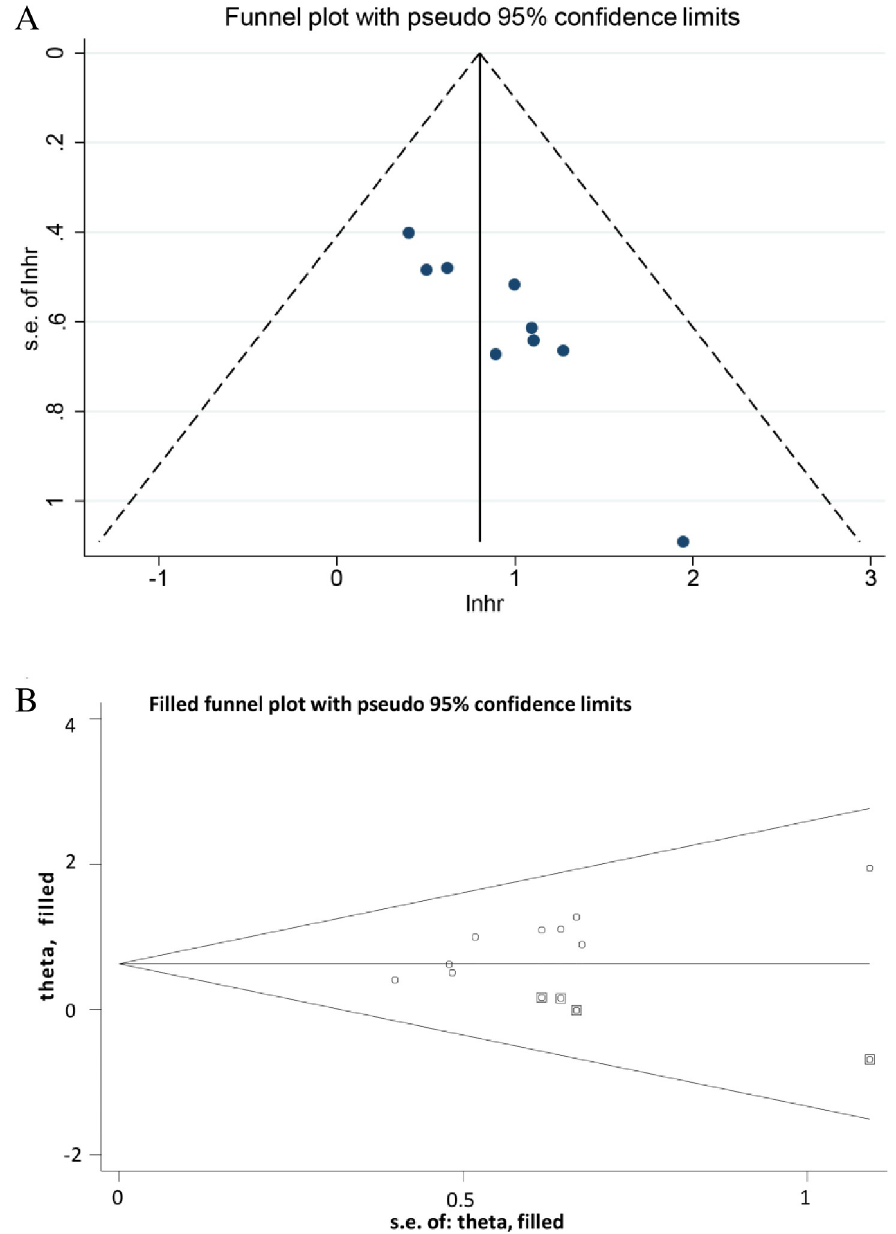
Fig 4. Test results of publication bias: A. before trim-and-fill method B. after trim-and-fill method.